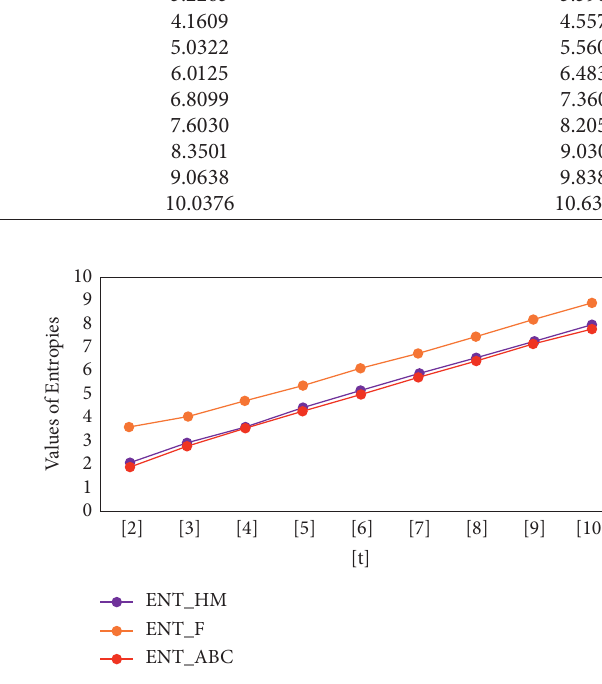
Figure 3: Comparison of entropies for hypertree CBT ( t ) .